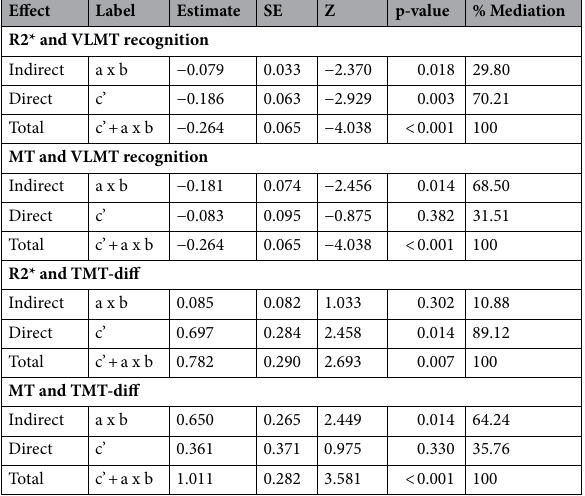
Table 4. Mediation estimates. Age served as predictor, VLMT recognition and TMT-diff as dependent variables, and R2* and MT as mediator. The labels a and b represent the indirect pathway, while c’ represent the direct